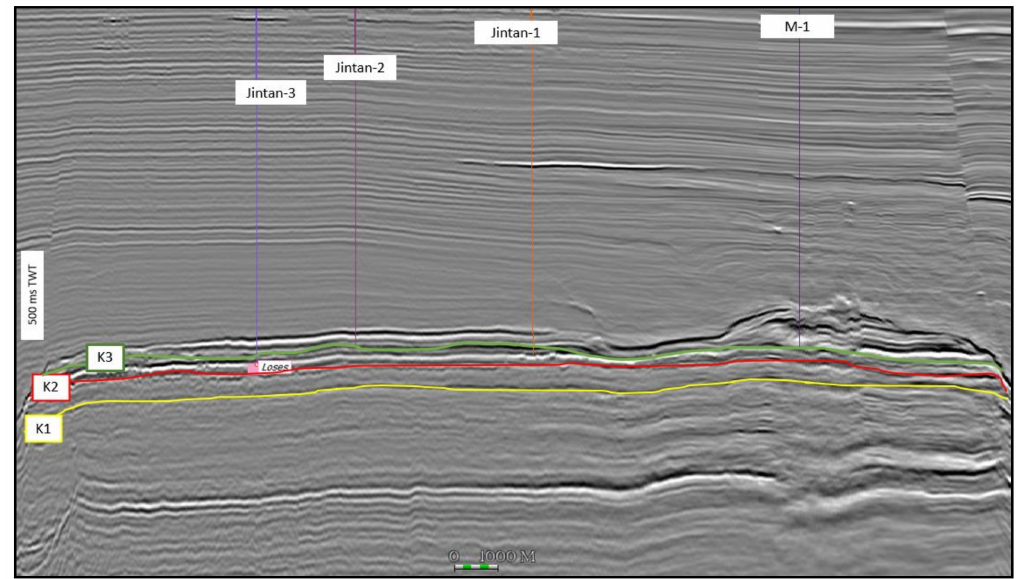
Figure 15. Horizon K1, K2 and K3 picked on different seismic unit (SU) intervals.